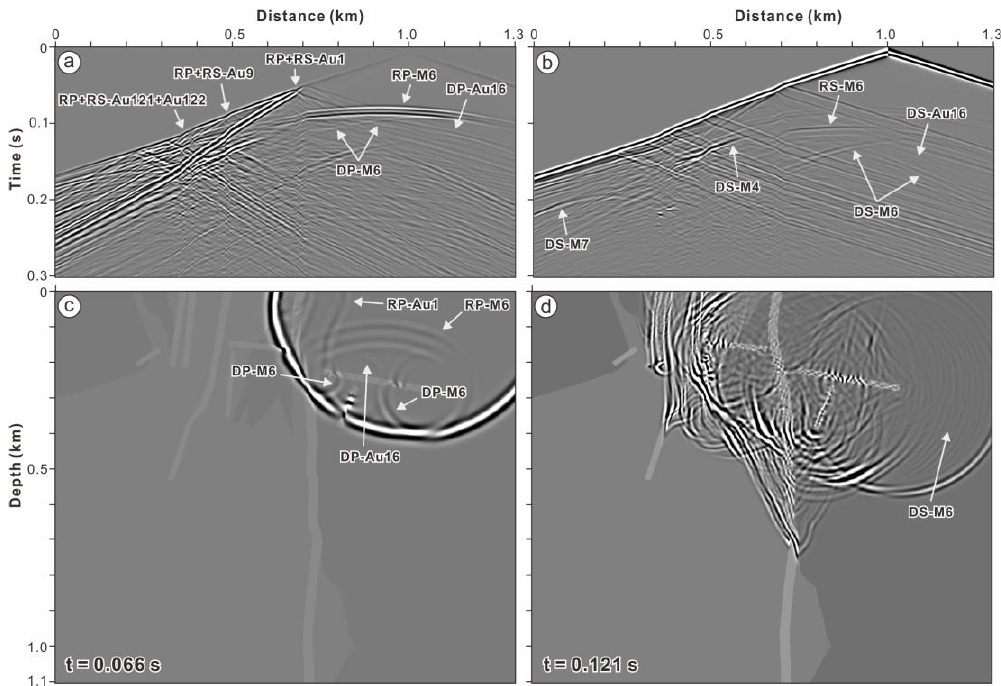
Figure 8. Elastic forward modeling results of the Zaozigou model. ( a ) The vertical component of the synthetic seismogram; ( b ) the horizontal component of the synthetic seismogram; ( c ) snapshot of P-wave wavefield at 0.066 s; ( d ) snapshot of S-wave wavefield at 0.121 s. The prefix “R” represents reflected events, and “D” represents diffracted events. The following “P” and “S” indicate P -waves and S-waves. For example, RP-M6 represents the reflected P-waves from M6 orebody. See rock properties in Table 4. A video on the vertical component of the simulated wavefield containing both P- and S-waves is available online at doi: www.mdpi.com/xxx/s1.